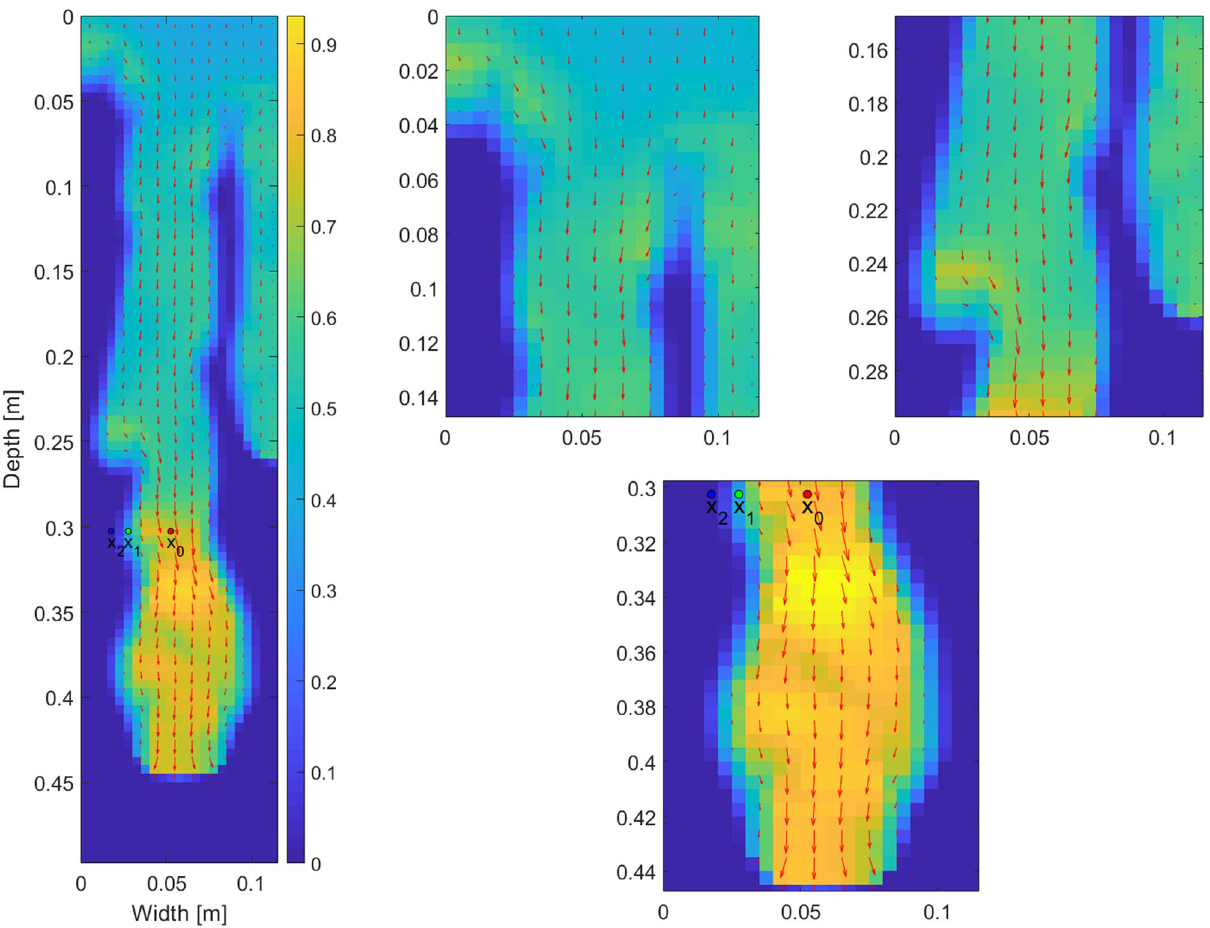
Figure 3. A manifestation of the mobile core and immobile fringe of a finger. Detail of the left-most finger in Fig. 2 at time 10 mins. Each arrow was produced by averaging the flux over four neighbouring blocks. Saturation values are colour-coded according to the colour bar on the